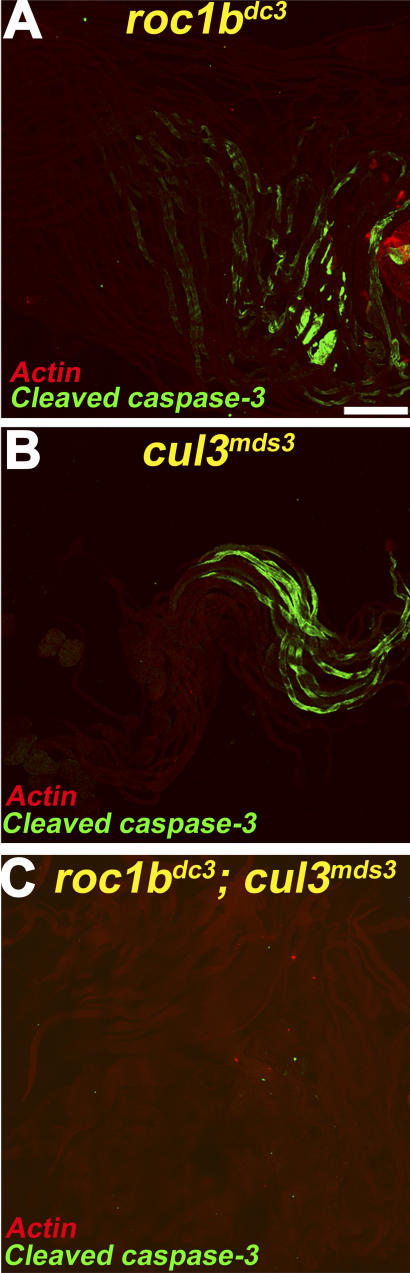
Double Mutants for cul3Testis and roc1b Block Caspase Activation During Spermatid DifferentiationTestes stained for cleaved caspase-3 (CM1, green) and spermatid's tail (phalloidin, red). (A) Spermatids in roc1b mutant flies (roc1bdc3
−/−) display severe individualization defects and still display some levels of CM1 staining. (B) Similarly, spermatids in flies homozygous for weak cul3Testis alleles, such as cul3mds3, also display some level of CM1 staining. (C) However, spermatids mutants for both roc1b and cul3Testis manifest a complete block in caspase activation during individualization.